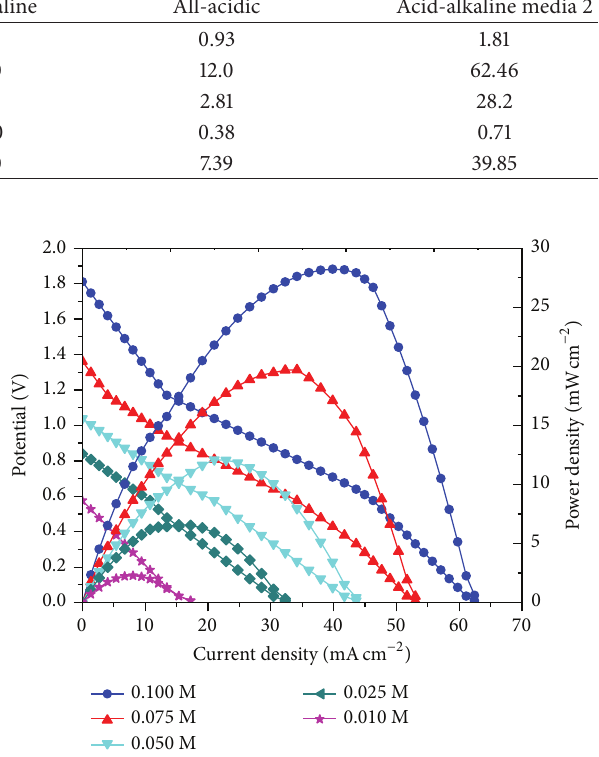
Figure 5: Effect of formic acid concentration on the current and power density of the MLSPBFC at room temperature. [Fuel]: 𝑥 M formic acid + 0.5 M NaOH. [Oxidant]: 0.1 M perborate + 0.5 M H 2 SO 4 . Stream flow rates: 0.3 mLmin −1 .